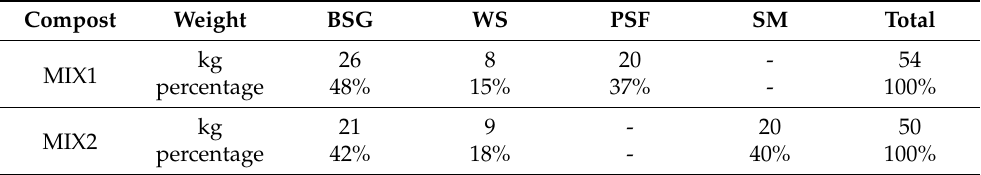
Table 2. The composition of the two mixtures, MIX1 and MIX2, included in the experiment. Compost